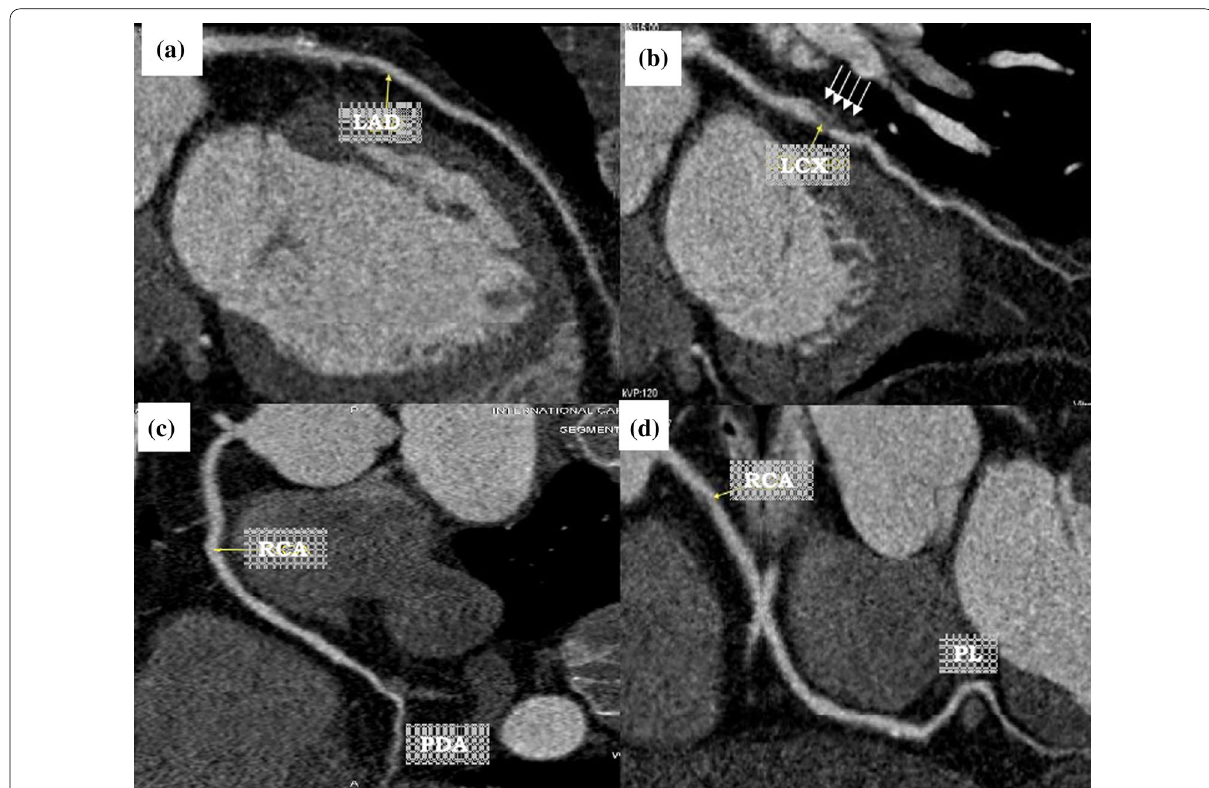
Fig. 3 A 48-year-old male patient with recurrent attacks of retro-sternal compressing pain. A – D CT angiographic showed mid-LCX segment significant stenotic segment (multiple arrows) with mild diffuse atherosclerotic changes of the rest of the coronary arteries with no significant lesions (CAD-RADS 4). E – H Conventional angiographic findings showed a significant stenotic lesion at mid-LCX segment (arrows) with mild diffuse atherosclerotic changes of the rest of the coronary arteries with no significant lesions in complete agreement with the CT